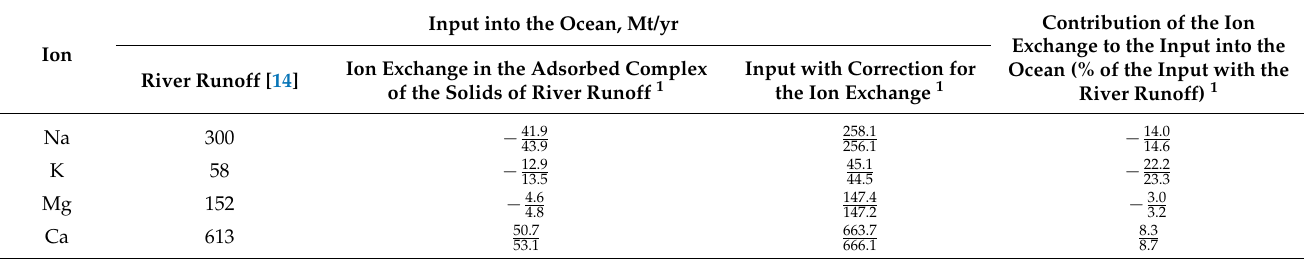
Table 3. Input of dissolved cations of the main salt composition with river runoff into the ocean with correction for the ion exchange in the adsorbed complex of solid substances.